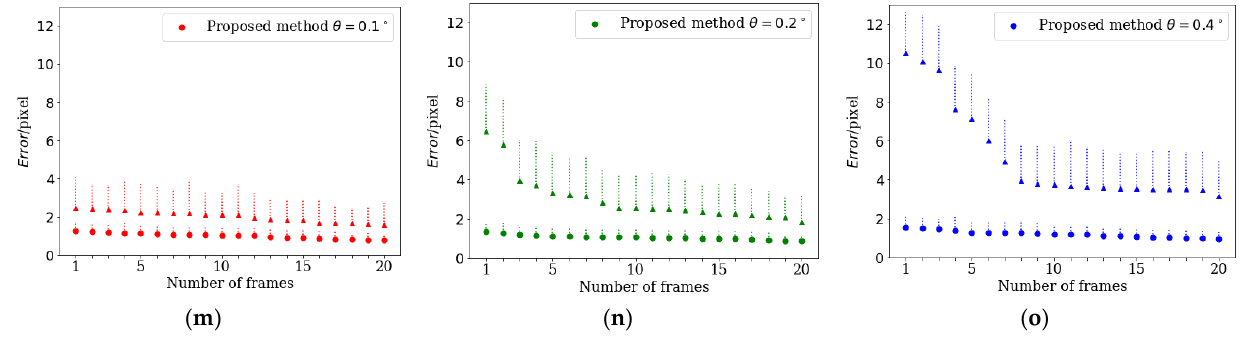
Figure 12. Re-projection error of different numbers of frames. The symbols and vertical lines represent the mean and 3 σ range of re-projection errors calculated by different methods. ( a – c ) are the results compared with [18], ( d – f ) are compared with [22], ( g – i ) are compared with [19], ( j – l ) are compared with [20], ( m – o ) are compared with [24]. Table 4. Calibration results of different methods.